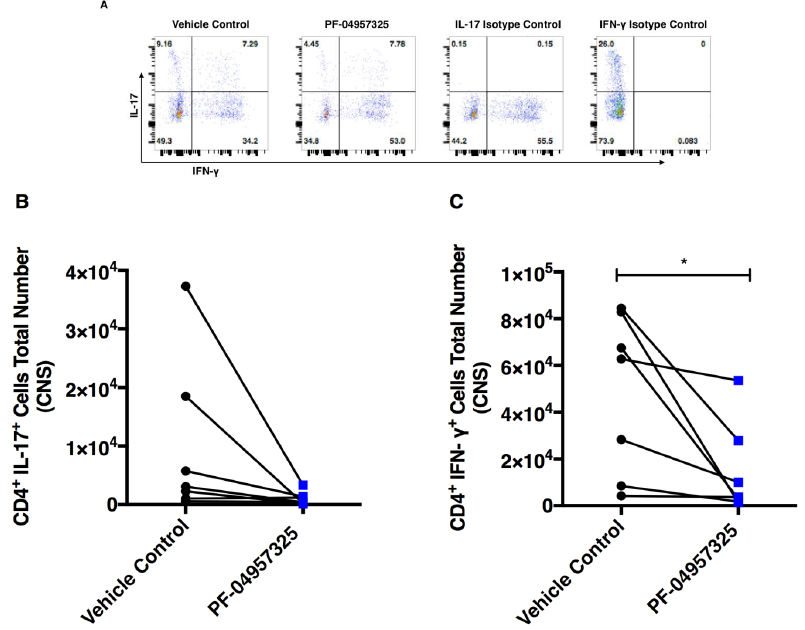
Figure 6. Treatment with PF-04957325 suppresses the accumulation of pro-inflammatory Th1 cells in the spinal cord. Mice with EAE scores of at least 1 were treated with the vehicle control or PF-04957325 thrice daily, for 6 to 13 days. ( A ) The detection of IL-17 + and IFN-γ + CD4 + cells after ex vivo restimulation with PMA/Ionomycin by flow cytometry in the spinal cord mononuclear cells of EAE mice treated with the vehicle control or PF-04957325. The representative dot plots show CD4 + T cells that are positive for IL-17 ( y -axis) and IFN-γ + ( x -axis). The data represent the total number of IL-17 + ( B ) and IFN-γ + CD4 + cells (* p = 0.04) ( C ) in the spinal cord (CNS). ( B , C ) n = 7 mice per group; mean ± SEM of four independent experiments.